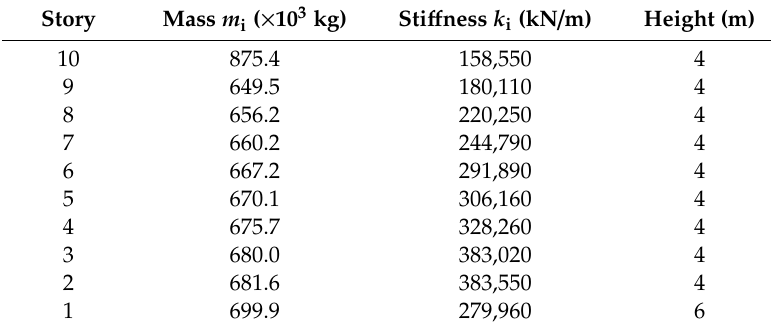
Figure 7. 10-story benchmark structure. Table 1. Characteristics of the benchmark